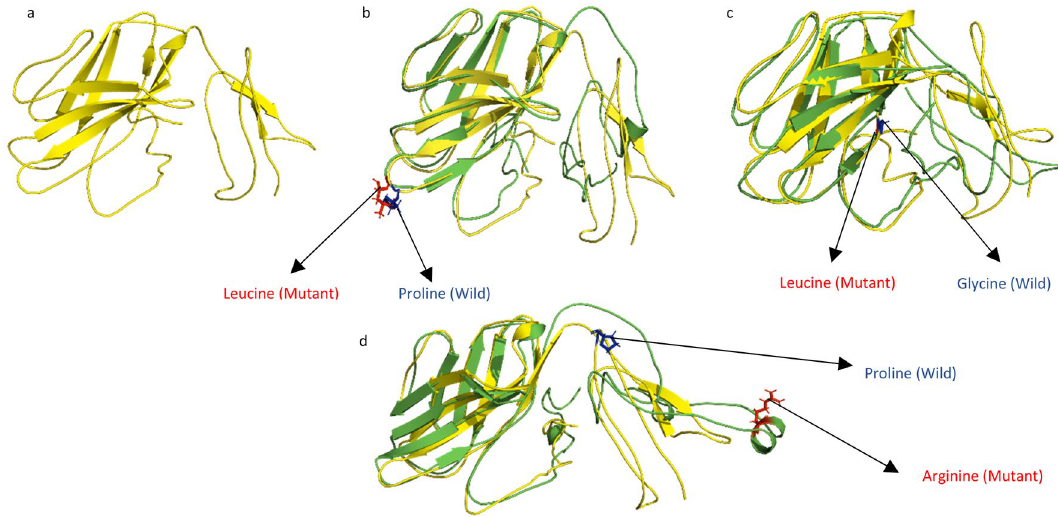
Figure 3. ( a ) Structure of Wild type CTLA4 protein. ( b ) Superimposed wild type CTLA4 protein and its mutant having Proline to Leucine mutation at position 137. ( c ) Superimposed wild type CTLA4 protein and mutant having Glycine to Leucine mutation at position 146. ( d ) Superimposed structure of wild type CTLA4 protein and mutant having mutation from Proline to Arginine at position